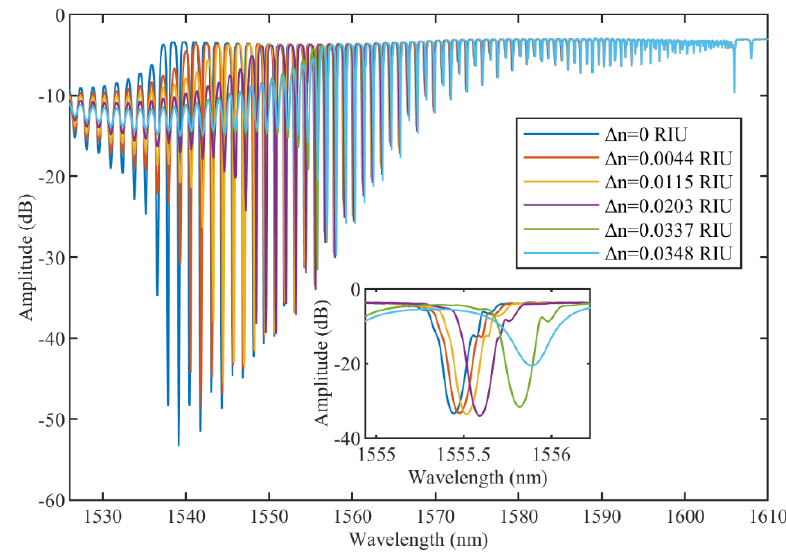
Figure 3. Spectral evolution of unetched TFBG subjected to surrounding RI variations. Inset reports effect on the cladding mode near 1555.5 nm.